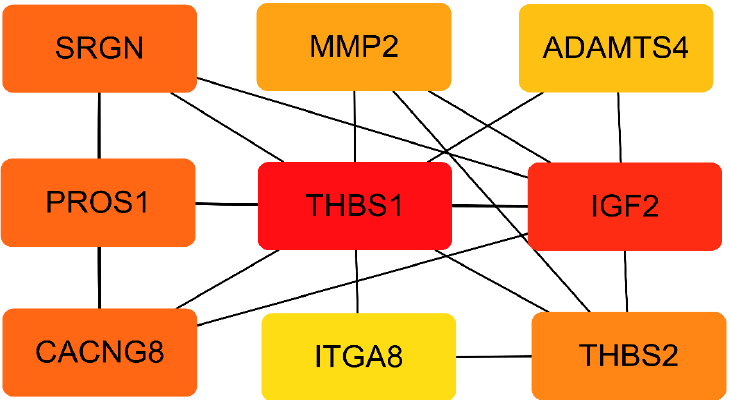
Figure 4. Identification of hub genes in the protein–protein interaction (PPI) network. Cytoscape’s plug-in CytoHubba uses the MCC algorithm to select the most important module from the PPI network. The darker the color, the higher the gene relatedness.